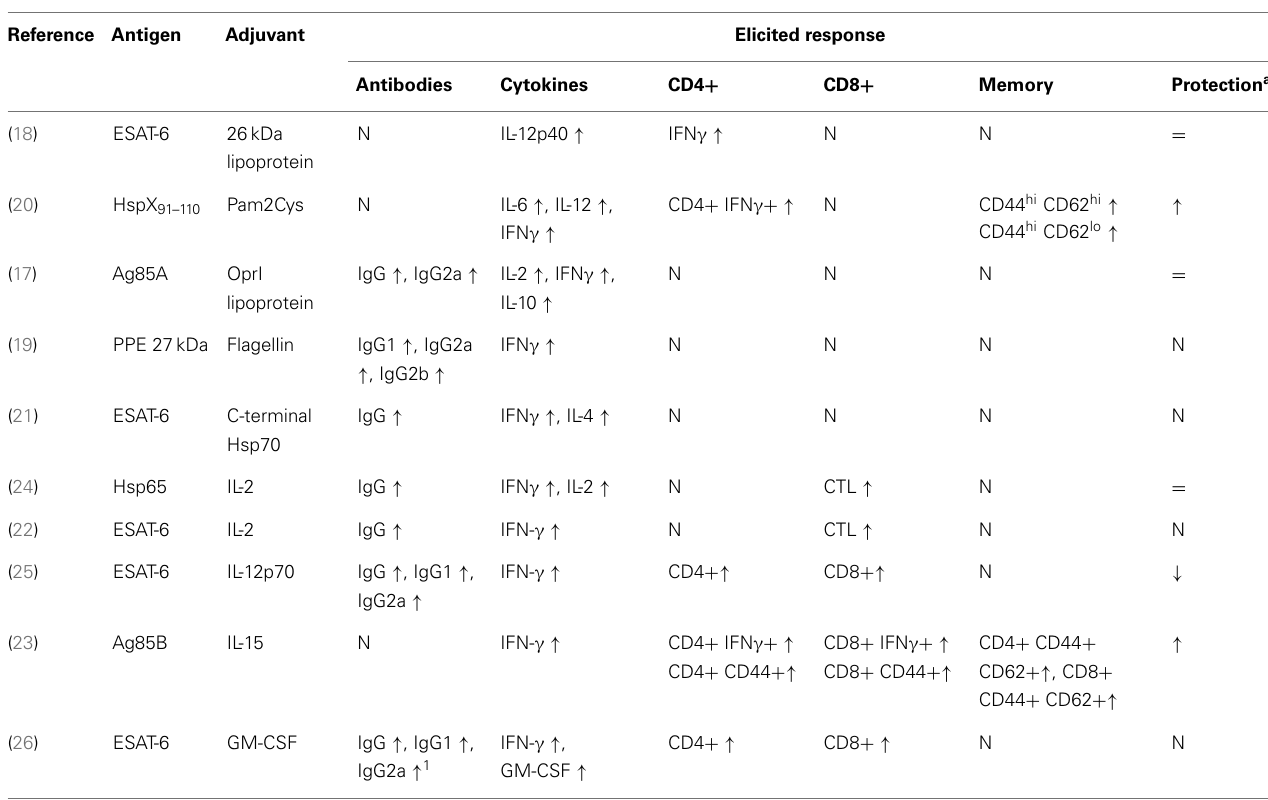
Table 1 | Reviewed studies that evaluated fusions of M. tuberculosis antigens with adjuvant molecules: molecules used and the generated immune response